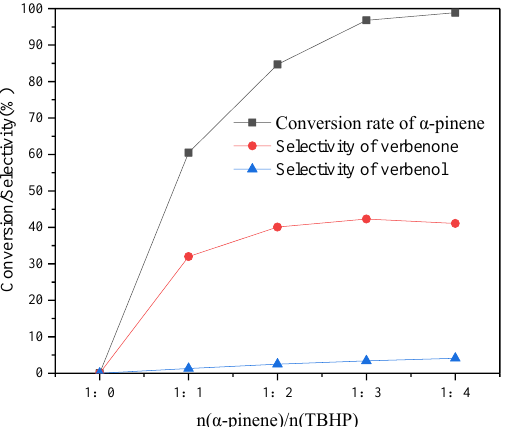
Figure 7. Variation of n(α -pinene):n(TBHP) in the oxidative synthesis of verbenone with TBHP. Reaction conditions: CuAPO-5(0.06) 100 mg, α -pinene 1 mmol, temperature 85 °C, TCM 10 mL, Reaction conditions: CuAPO-5(0.06) 100 mg, α -pinene 1 mmol, temperature 85 ◦ C, TCM 10 mL, reaction 12 h. reaction 12